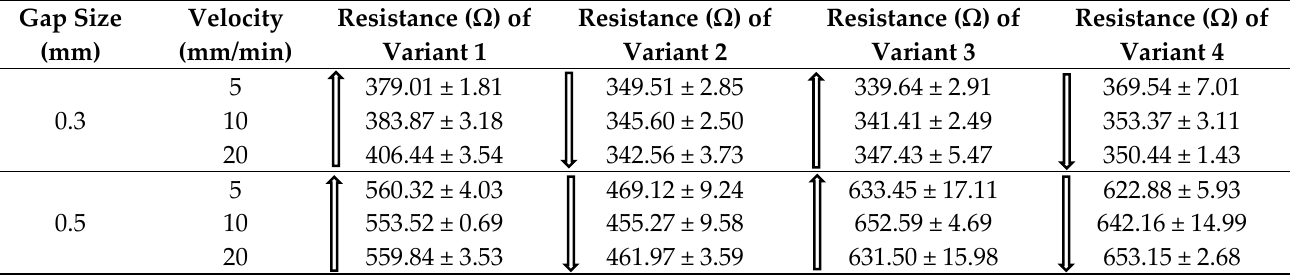
Table 4. Mean values and standard deviation of resistance in ohms, calculated from the lowest resistance value reached in each of the five actuations for each measurement. Note that due to resistive path shortening, a high force and deformation coincide with a low, rather than a high extreme in resistance. The arrows indicate the order in which measurements were performed.